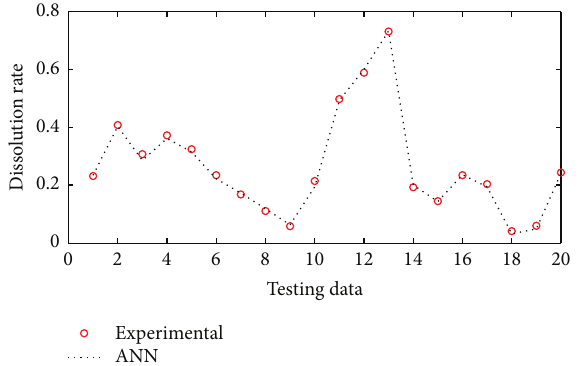
Figure 7: Comparison of ANN and experimental results for the testing results.